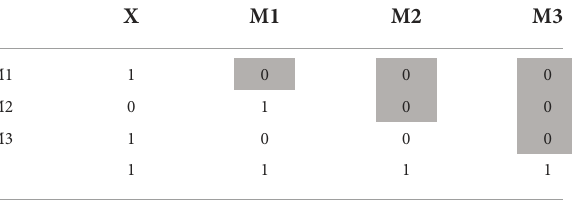
TABLE 1 B matrix specifying whether (1) or not (0) antecedent variables have an effect on consequent